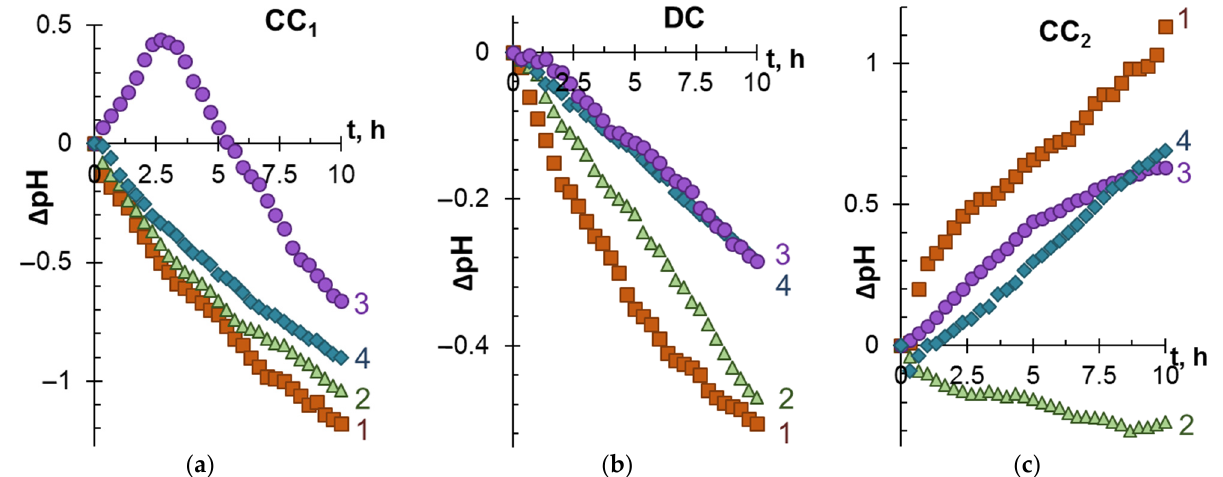
Figure 4. Differences between the current and initial pH values in the CC1 ( a ), DC ( b ) and CC2 ( c ) tracts vs. duration of electrodialysis of model solutions. The numbers of the curves correspond to the designations of the solutions in Table 2.